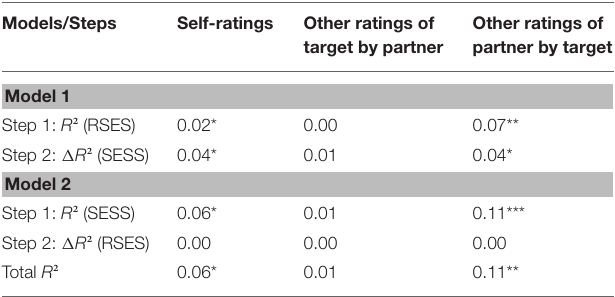
TABLE 5 | Head-to-Head Comparisons of the RSES and SESS in the Concurrent Prediction of Relationship Satisfaction (RAS) in a Multiple Regression Analysis.